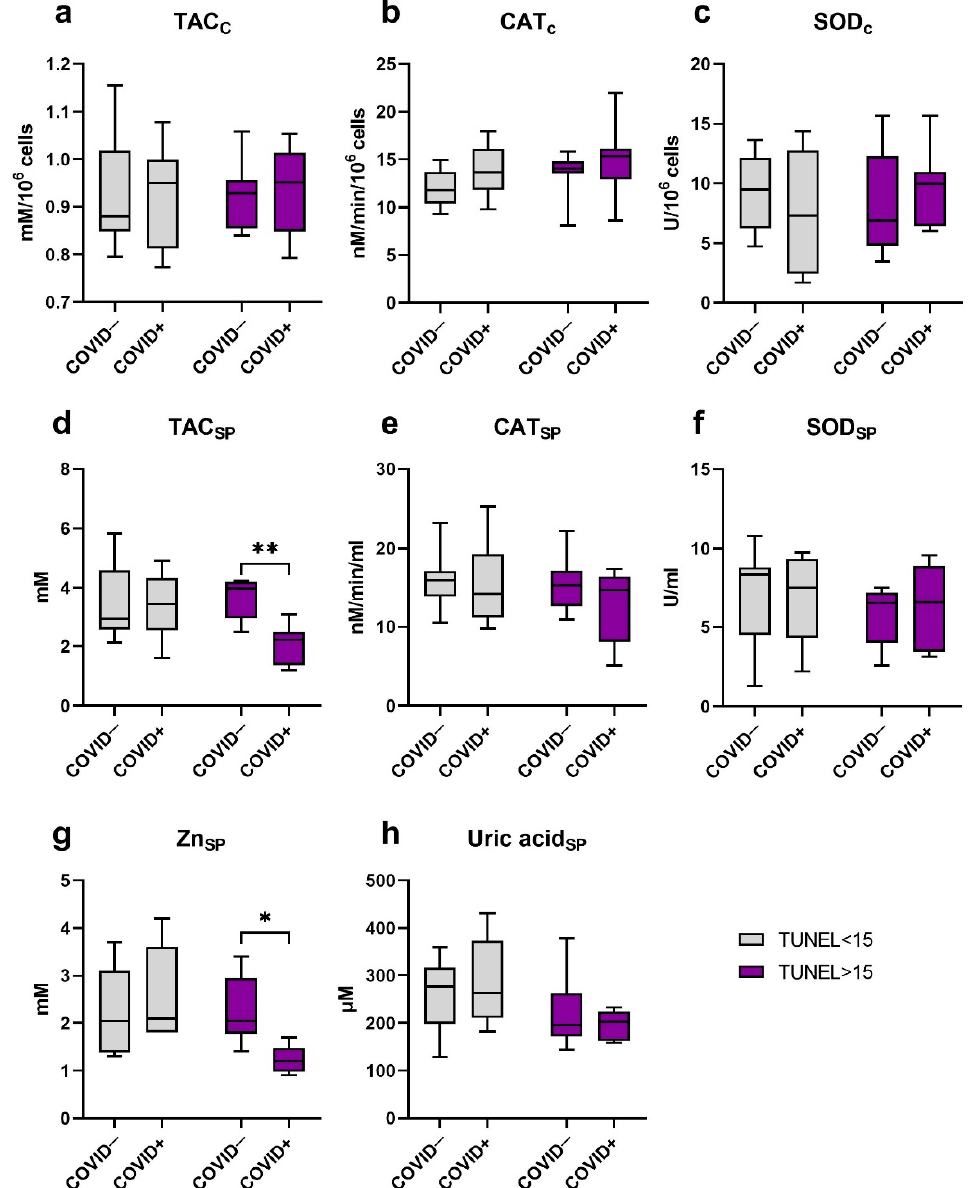
Figure 2. The antioxidant components level in sperm and seminal plasma of men after COVID-19, depending on DNA fragmentation level. ( a ) Total antioxidant capacity in cells. ( b ) Catalase activity in cells. ( c ) Superoxide dismutase activity in cells. ( d ) Total antioxidant capacity of seminal plasma. ( e ) Catalase activity in seminal plasma. ( f ) Superoxide dismutase activity in seminal plasma. ( g ) Zn level in seminal plasma. ( h ) Uric acid concentration in seminal plasma. C (subscript)—cellular; SP (subscript)—in seminal plasma. Values are expressed as Me [25, 75%], whiskers—min-max. Significance of difference between the «COVID − , TUNEL<15» and «COVID+, TUNEL<15», as well as «COVID − , TUNEL>15» and «COVID+, TUNEL>15» groups were determined by the Mann–Whitney U test. *— p ≤ 0.05; **— p ≤ 0.01.